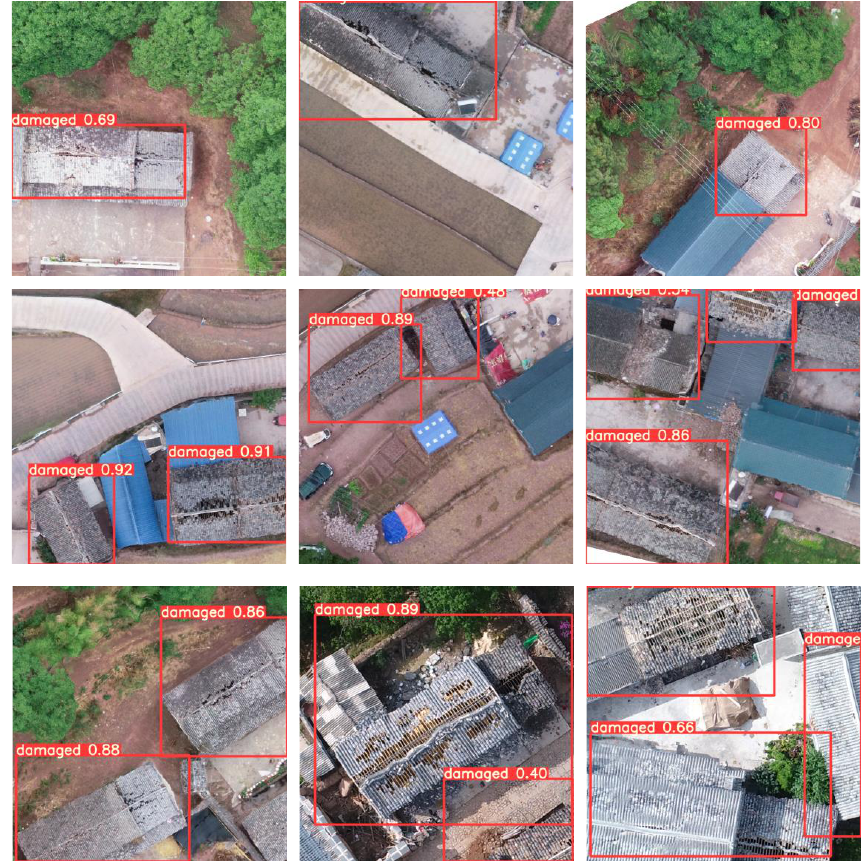
Figure 15. The examples of detection results by YOLOv5s-ViT-BiFPN. Table 2. The comparison of visual interpretation and automatic detection for damaged houses in the 5 test areas.